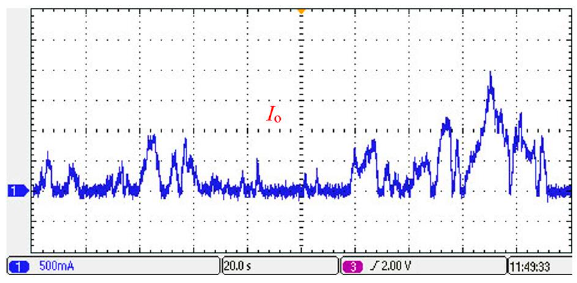
Figure 20. The converter load current waveform under the WLTP.